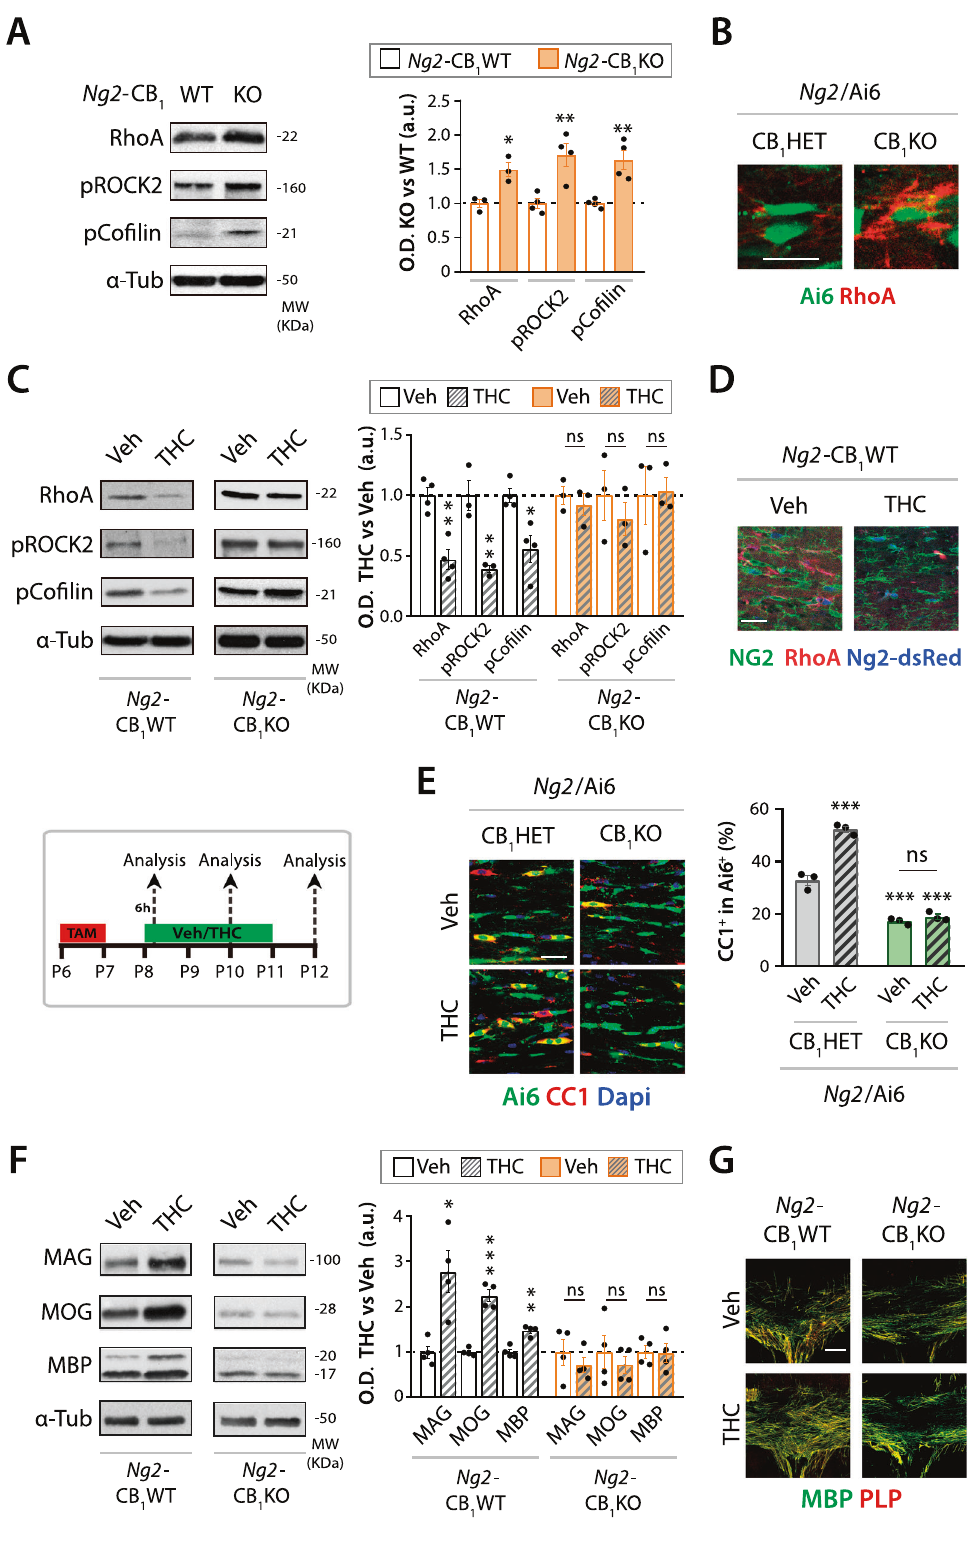
modulate RhoA protein levels we used a reversible proteasome inhibitor, MG-132. Thus, pretreatment with MG-132 prevented the THC-induced reduction in RhoA protein levels in CC extracts (Fig. 5A), as well as the THC-induced OL differentiation determined by immuno fl uorescence analysis in the CC of Ng2 /Ai6-CB 1